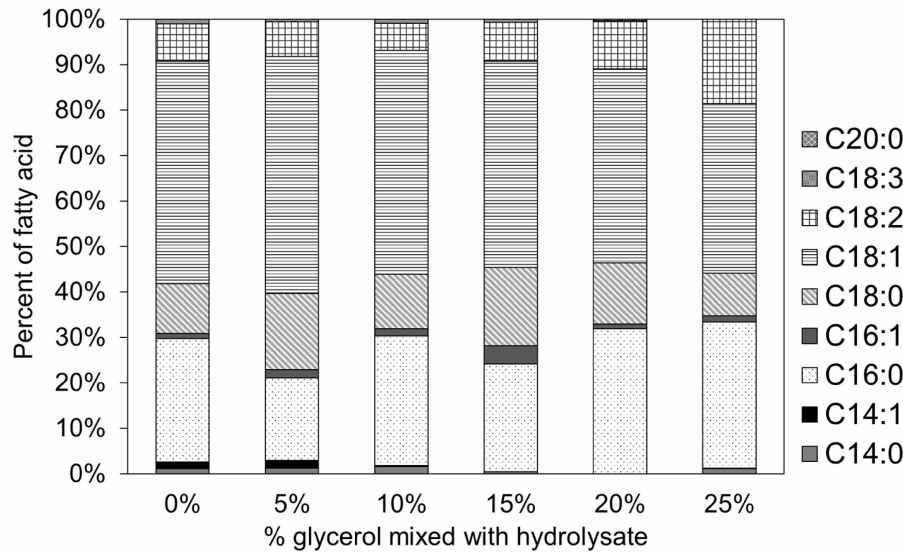
Figure 8. Fatty acid profiles when culturing R. glutinis TISTR 5159 in sugarcane bagasse hydrolysate mixed with various amount of